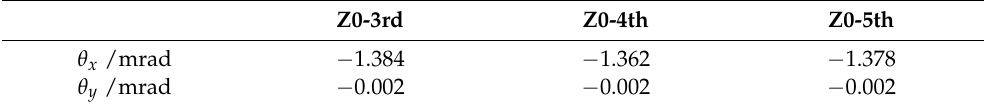
Table 2. Calibration results of the constant error for the scanning angles of CE-3’s TDI. Z0-3rd θ x